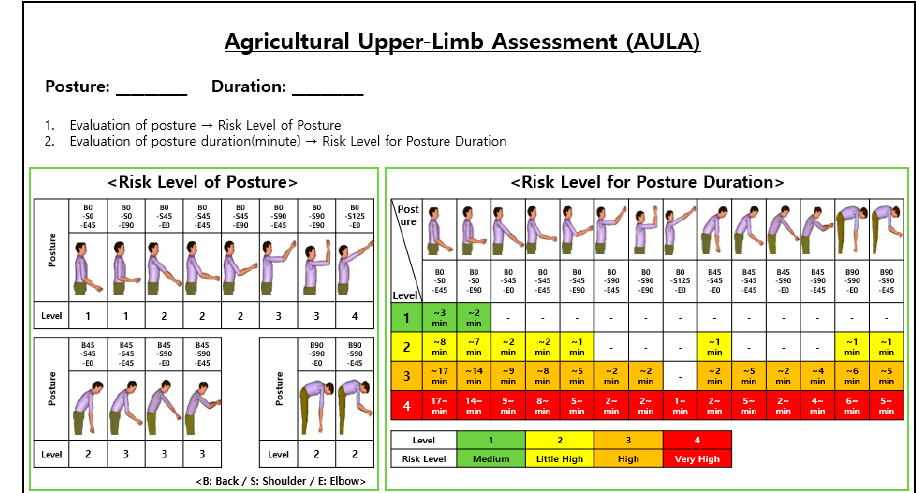
Figure 2. Agricultural upper limb assessment (AULA).